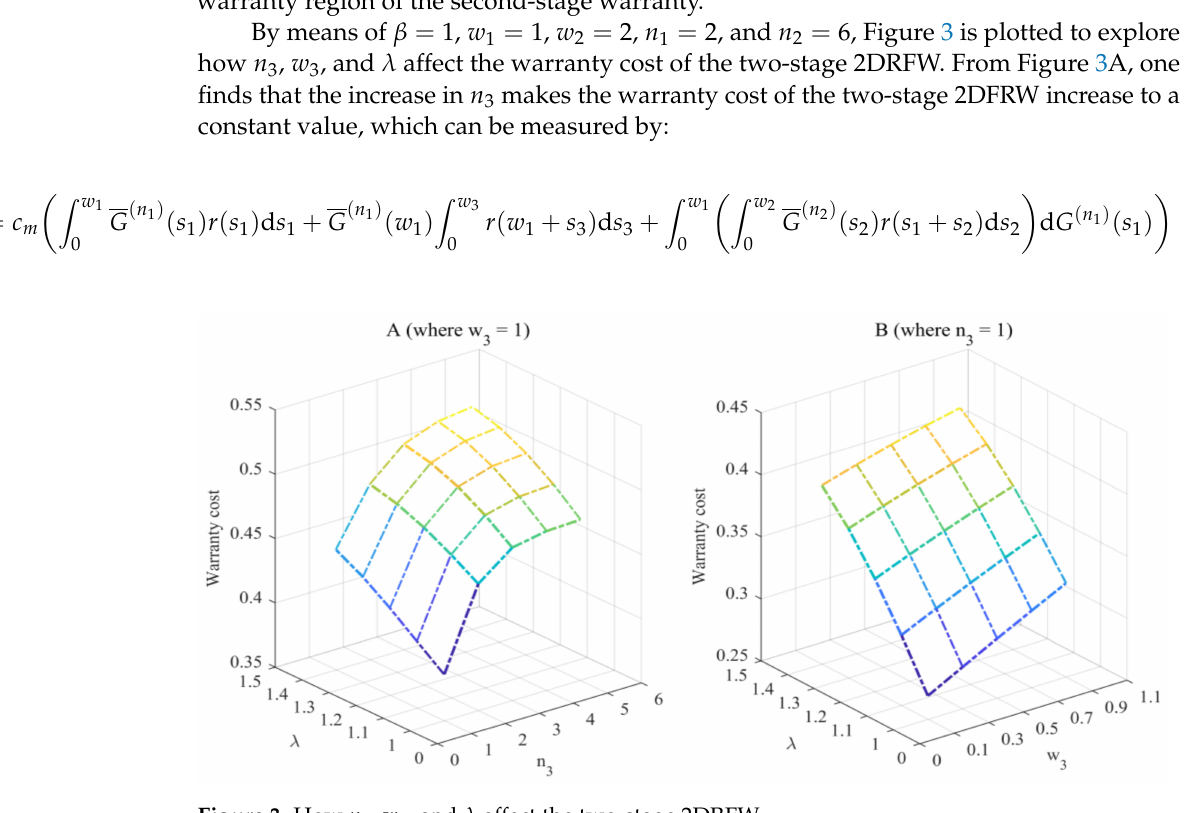
Figure 3. How n 3 , w 3 , and λ affect the two-stage